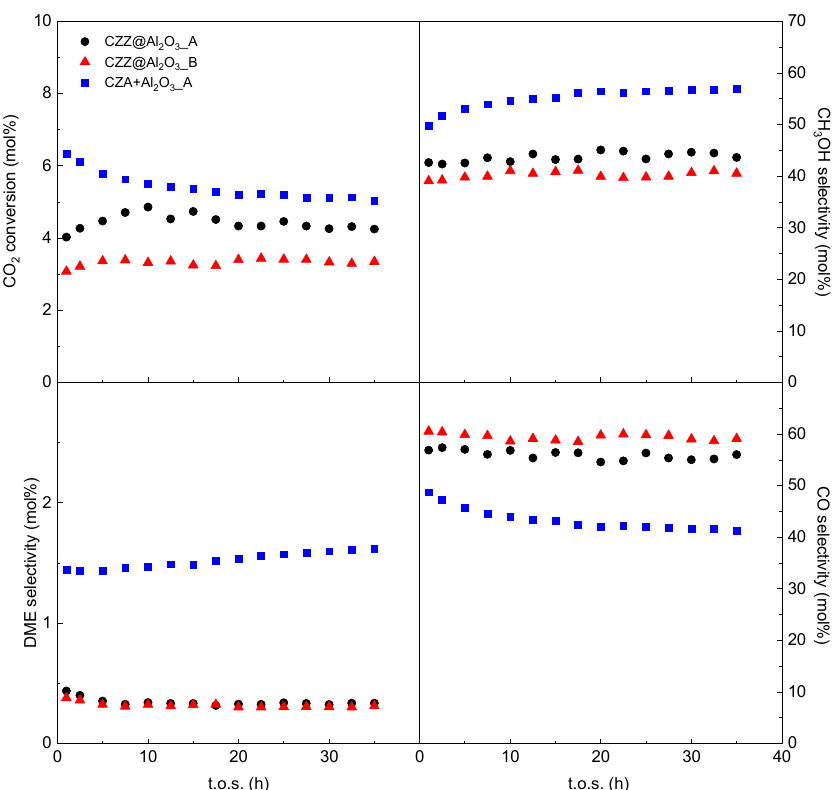
Figure 9. CO 2 conversion and products selectivity as a function of time-on-stream (t.o.s.) for the CZZ@Al 2 O 3 _A ( ) and CZZ@Al 2 O 3 _B ( ) composites and for the CZA + Al 2 O 3 _A physical mixture ( ). Reaction conditions: T = 250 °C, P = 3.0 MPa, H 2 :CO 2 molar ratio = 3:1, GHSV = 48,000 Ncm 3 g cat − 1 h − 1 .